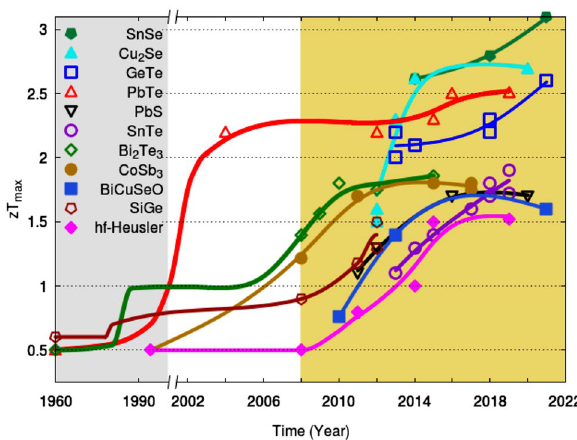
Figure 2. Upper zT -envelopes constructed from the existing data for: SnSe 9–11 , Cu2Se 12–16 , GeTe 17–22 , PbTe 23–27 , PbS 28–31 , SnTe 32–39 , Bi 2 Te 3 40–44 , Skutterudites 45–49 , BiCuSeO 50–52 , SiGe 53–56 , Half-Heuslers 57–61 . The lines are only for differentiating one group of materials from the